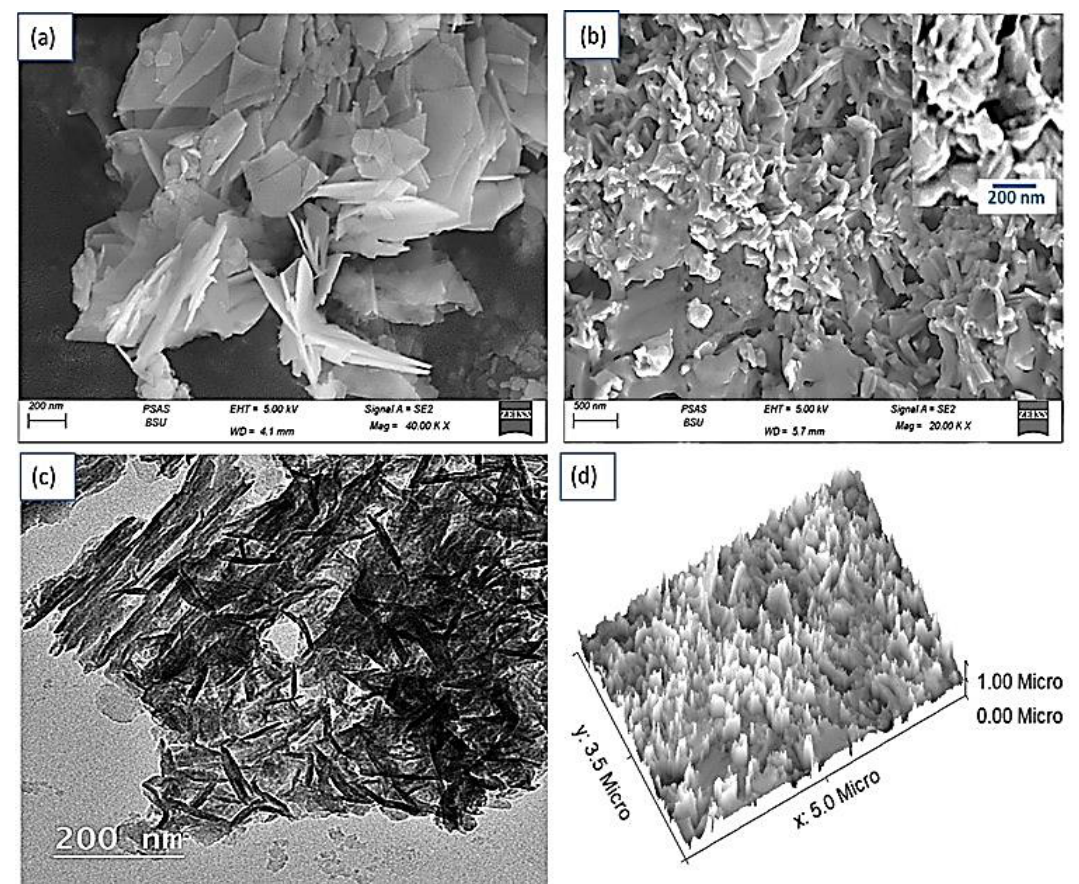
Figure 3. SEM of ( a ) G-C3N4 and ( b ) NiS-NiO-G C3N4 composite. ( c ) TEM and ( d ) theoretical image for cross-section and roughness of NiS-NiO/G-C3N4 composite.